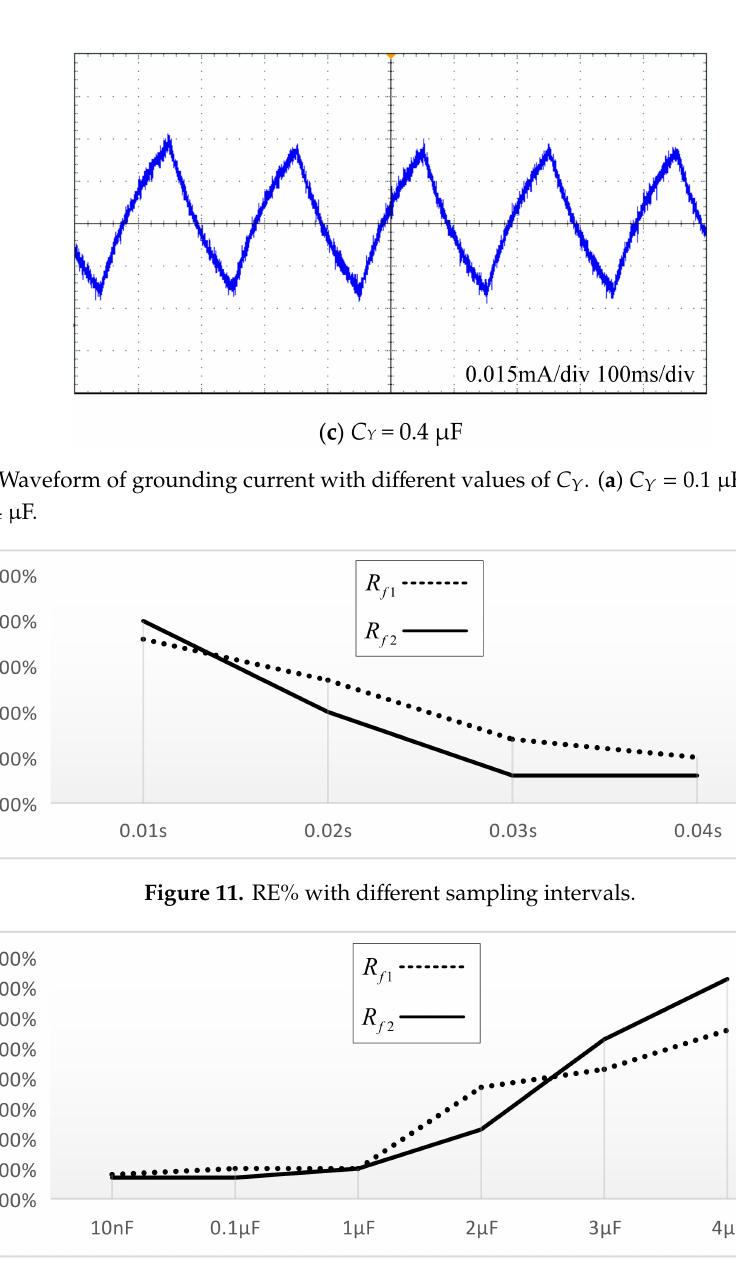
Figure 12. RE% with di ff erent values of CY.